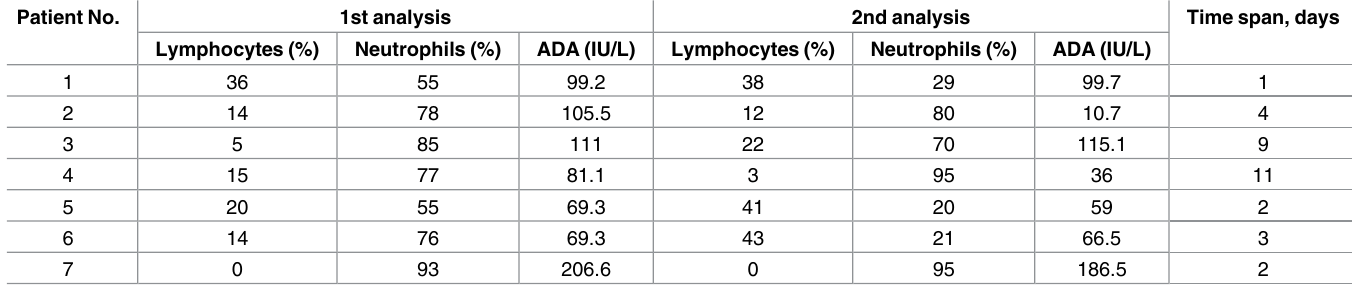
Table 5. Consecutive Pleural Fluid Analysis of Patients with Neutrophil-Predominant Pleural TB. Patient